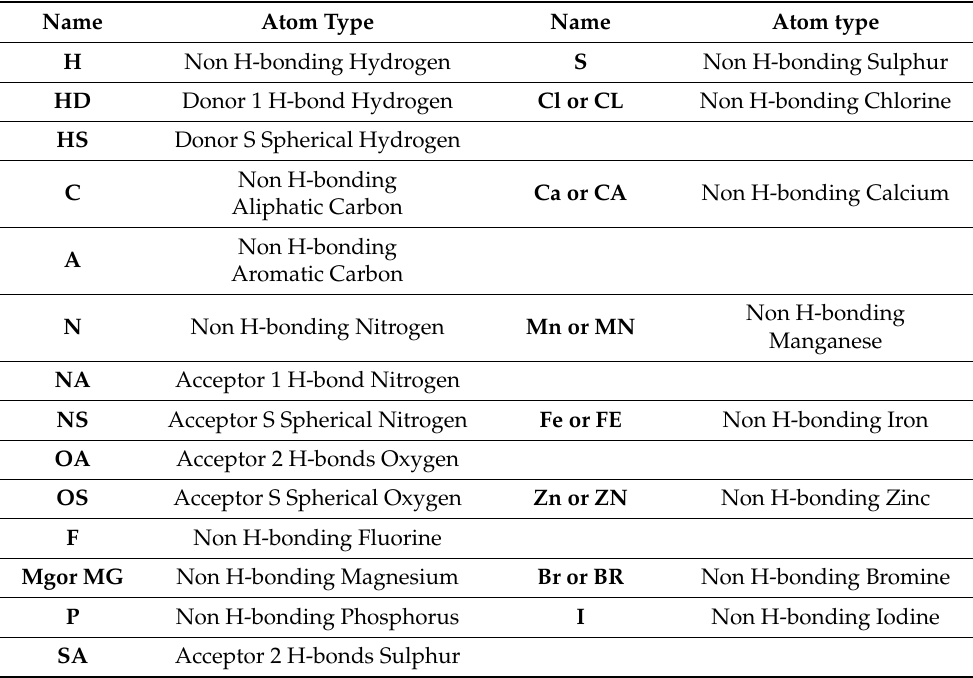
Table 2. Atom type available for AMIDE based on AutoDock